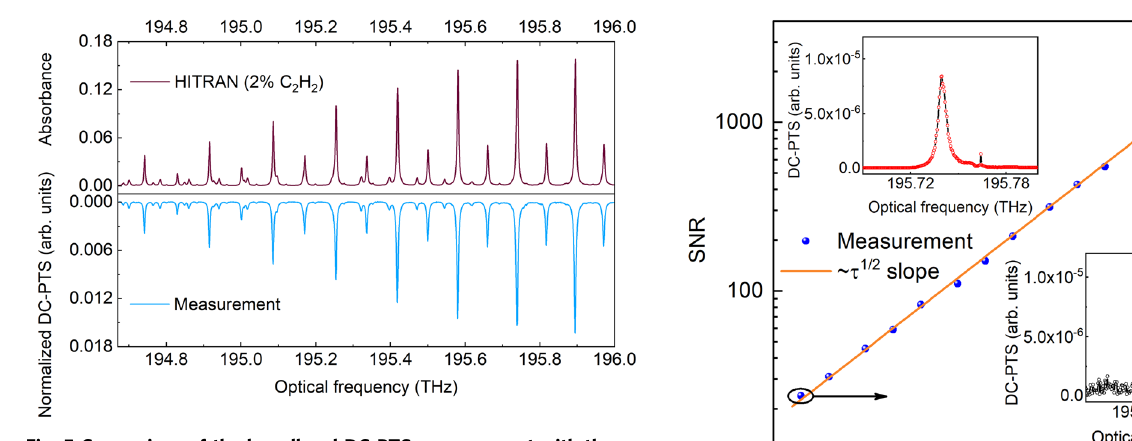
Fig. 5 Comparison of the broadband DC-PTS measurement with the spectral simulation based on the HITRAN database. The gas mixture of 2% C 2 H 2 is used in this test. The multi-heterodyne photothermal signal is normalized to account for the non-uniform comb intensity distribution and FPI response over broadband.